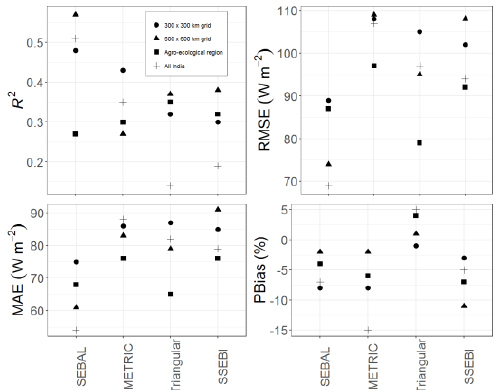
Figure 2. Model evaluation metrics of the four contextual based SEB models using the four spatial domains.